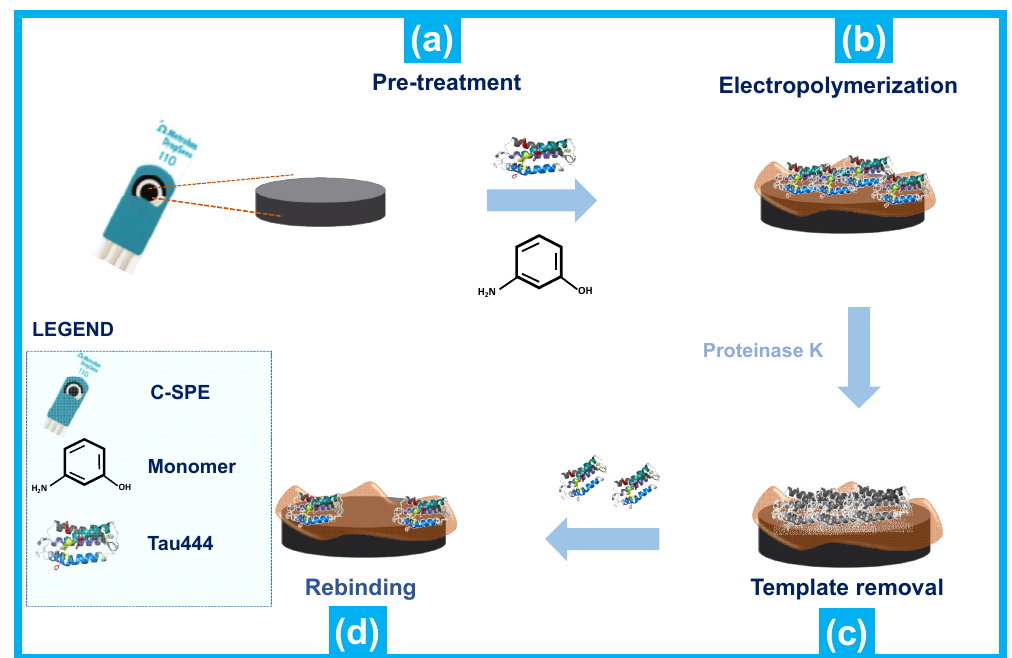
Figure 1. Schematic diagram of the electrochemically assisted MIP strategy and the sequence of reactions involved in the impedimetric transduction at C-SPEs for the determination of Tau protein.